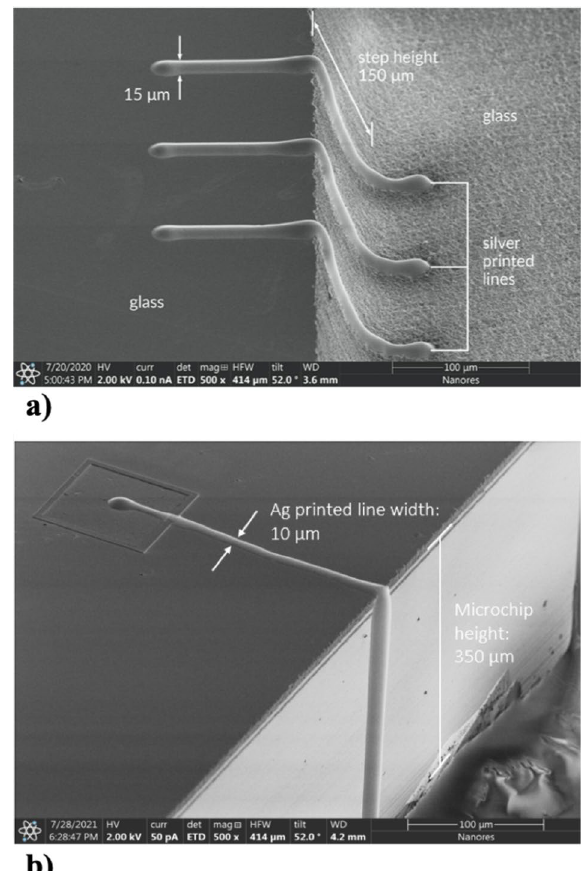
Figure 12. ( a ) Repeatable and continuous silver lines with a width of 15 µm printed on the step with the height of 150 µm, ( b ) 10 µm wide silver line printed on a microchip with the height of 350